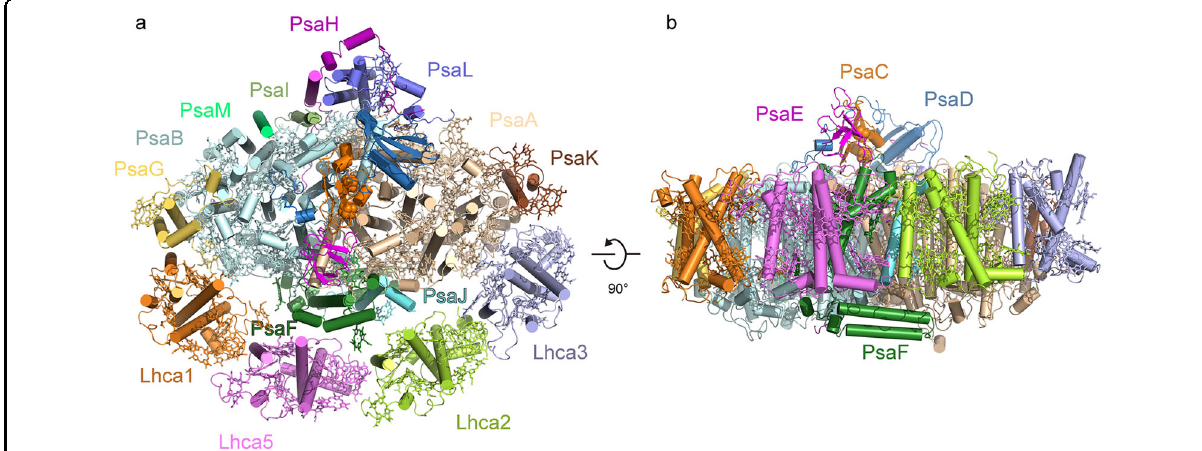
Fig. 1 Overall structure of the PSI – LHCI supercomplex from P . patens . a View from the stromal side. b Side view along the membrane plane. Color codes: PsaA, wheet; PsaB, palecyan; PsaC, lightorange; PsaD, skyblue; PsaE, magenta; PsaF, forest; PsaG, yelloworange; PsaH, purple; PsaI, splitpea; PsaJ, cyan; PsaK, brown; PsaL, slate; PsaM, green; Lhca1, orange; Lhca5, violet; Lhca2, limon; Lhca3,